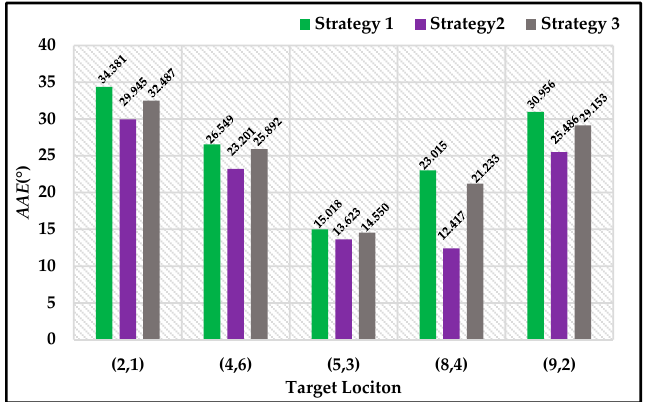
Figure 13. AAE results when the three proposed strategies were applied separately. The green histograms denote Strategy 1, the purple histograms denote Strategy 2, and the grey histograms denote Strategy 3.